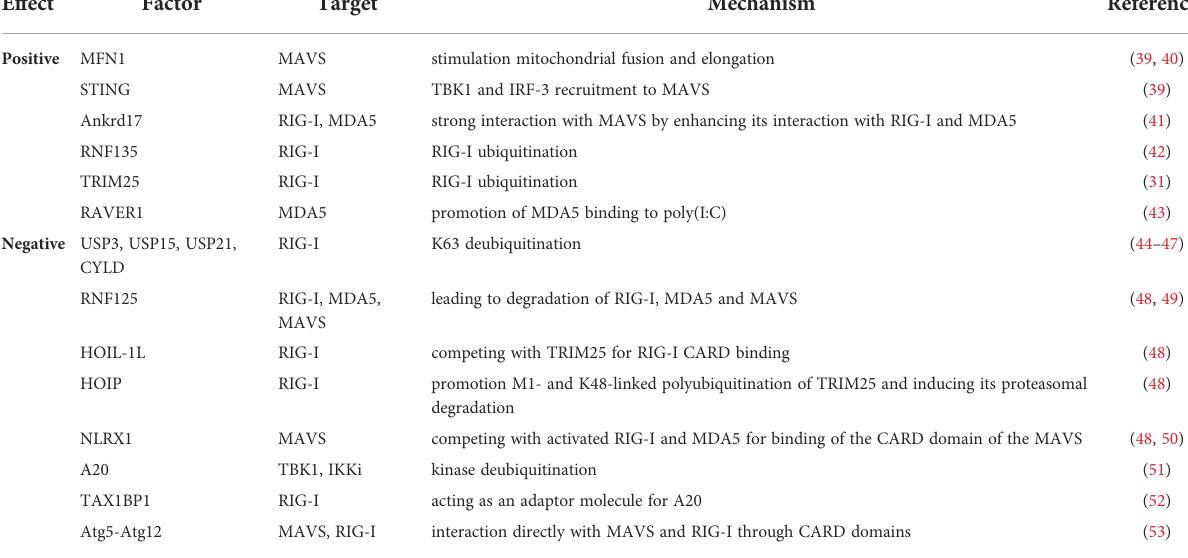
TABLE 2 Factors affecting activation of the RIG-I-like receptor-dependent signaling pathway.